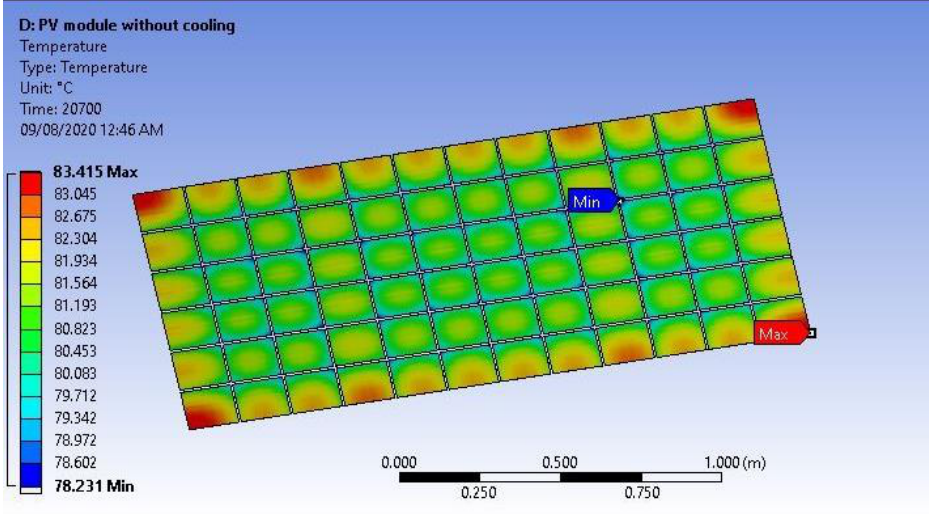
Figure 11. CAE temperature contour of a solar panel without cooling.